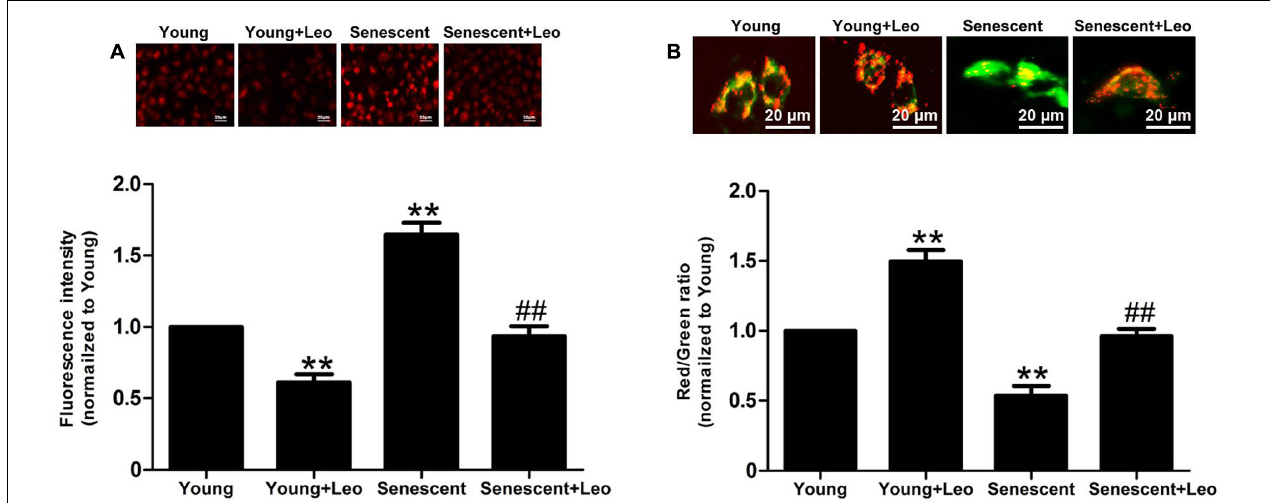
FIGURE 9 | Leonurine reduces the mitochondrial oxidative stress and restores the mitochondrial functions in senescent HUVECs. (A ) The effects of aging and leonurine on mitochondrial superoxide detected by MitoSOX. (B) The effects of aging and leonurine on mitochondrial membrane potential assessed by the red/green ratio of JC-1 staining. ∗∗ p < 0.01 vs. young group; ## p < 0.01 vs. senescent group. Data are mean ±